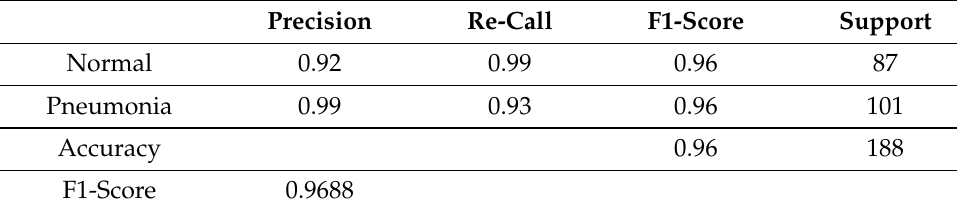
Table 6. Result analysis of the Inception V3